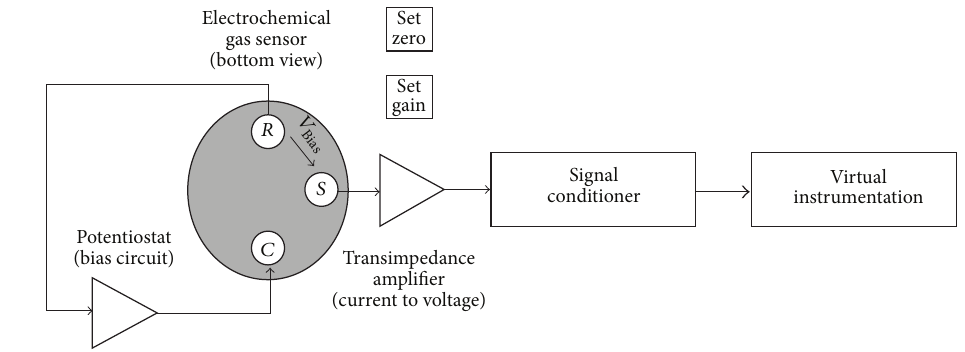
Figure 3: Block diagram of a typical gas detection system.